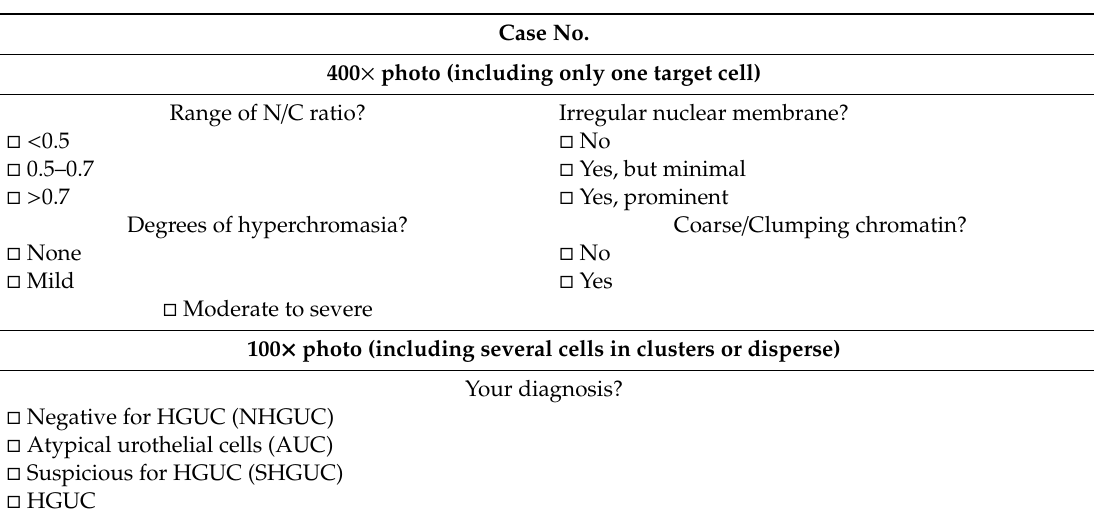
Table 4. Survey Form (translated) *.